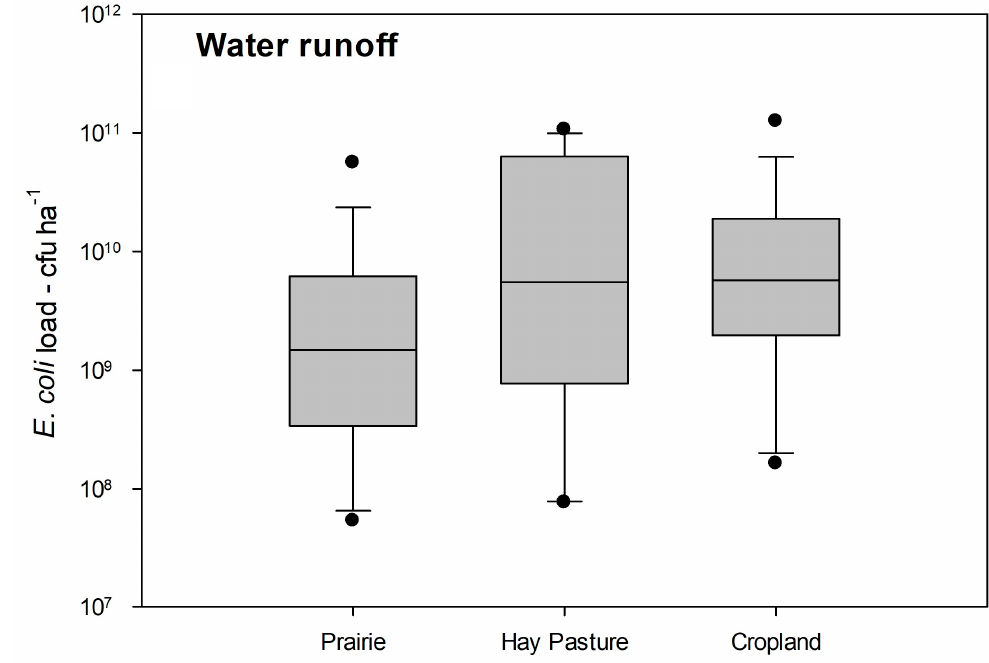
Figure 2. Box plots displaying E. coli load within the three sites from water runoff. The line within each box indicates the median value. The whiskers above and below the box indicate the maximum and minimum values of E. coli load within the three sites, and the dots indicate the outliers in the dataset.